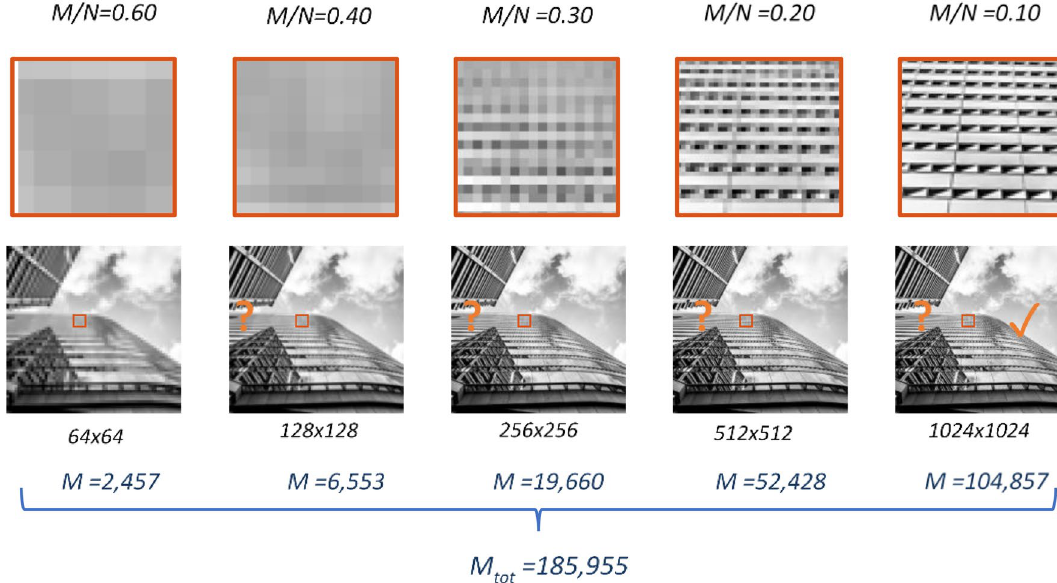
Figure 1. Illustration of CS reconstruction of an image of a multi-story building at different resolutions. The images are sorted from low resolution to high, from left to right. M denotes the number of samples that must be taken to sample at the compression ratio M / N , specified in the top row. The square area outlined in red is enlarged in the row above each image to illustrate the increase of fidelity at each